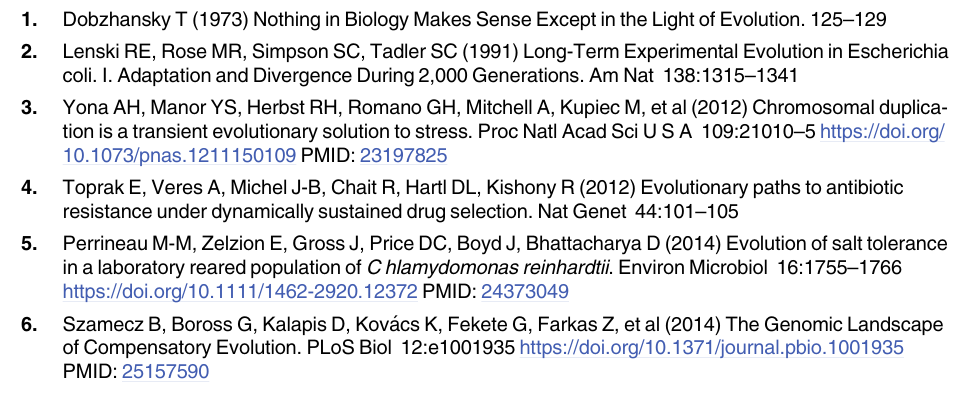
S5 Fig. In silico pairwise competition simulation of daily dilution strategy against every other strategy. In order to assess the fitness of each strategy relative to that of the daily dilution strategy, we have used a simulation that is based on an expanded form of the logistic equation (see S3 Text). The simulation uses the parameters extracted from the individual growth curves done in 20˚C and 15˚C ( Escherichia coli and Saccharomyces cerevisiae , respectively). Each sub- plot shows the results for a single strategy (lower bar) compared to that of daily dilution (upper bar): (A) E . coli , (B) S . cerevisiae . Color bar represents the number of cells from